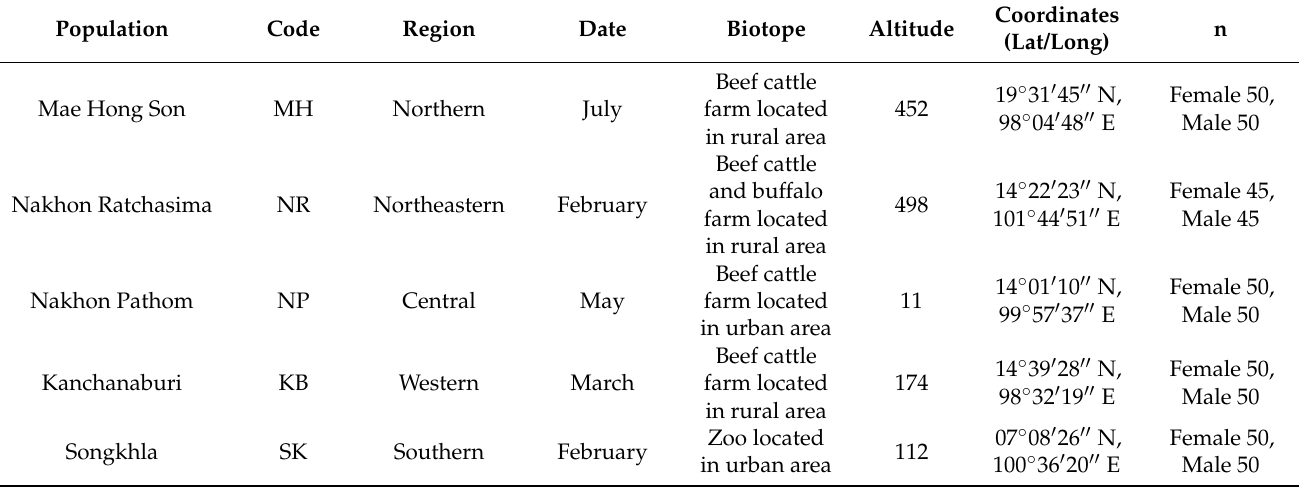
Table 1. Population, date, and number (n) of wing images of S. calcitrans used for the landmark-based geometric morphometric